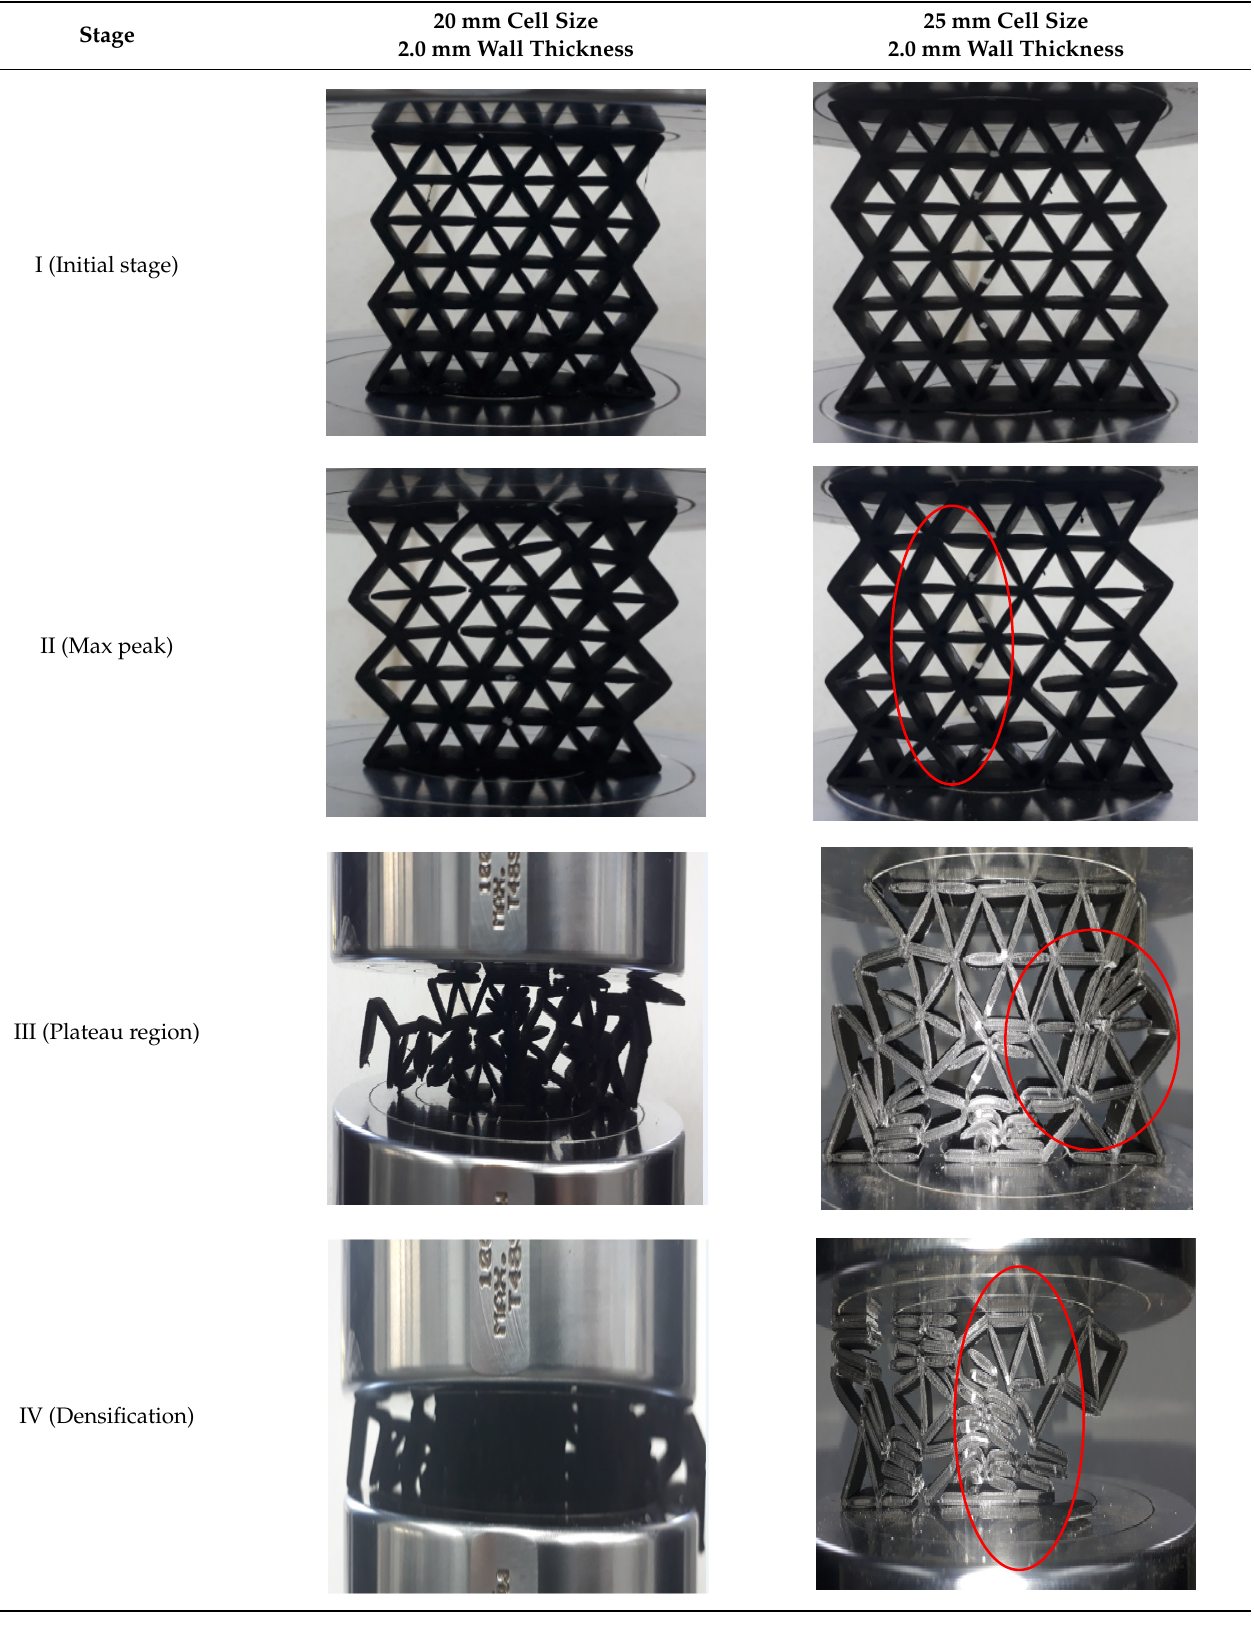
Table 2. Comparison of structure failure deformation under different cell sizes.